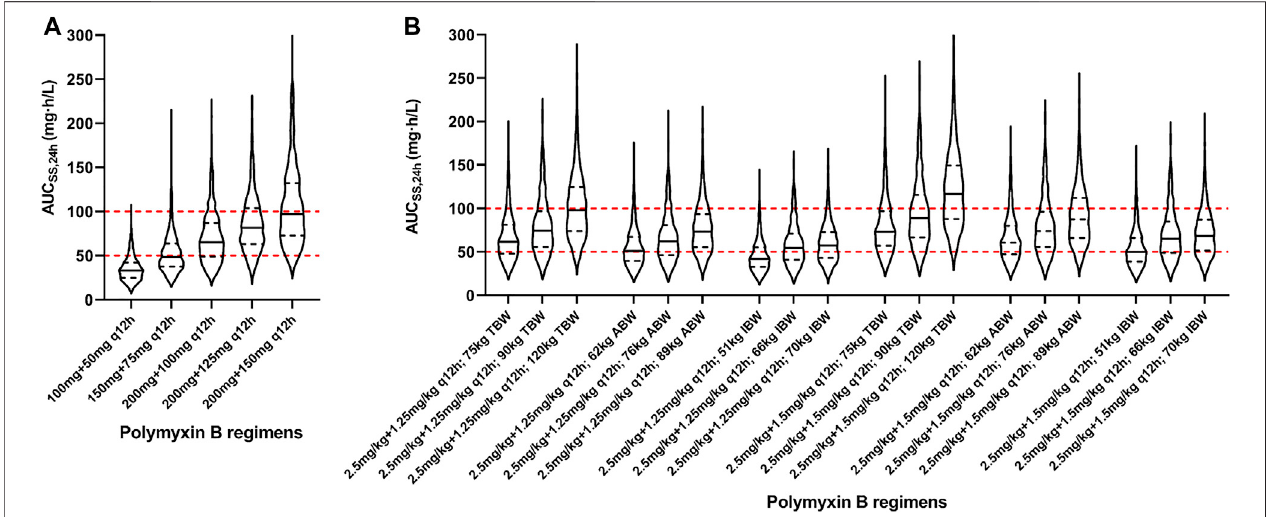
FIGURE 4 | Violin plot of simulation results of polymyxin B exposures (AUC ss,24h ). (A) Five fi xed regimens; (B) Bodyweight-based regimens. The dot lines present the interquartile of simulated exposure; the solid lines present the median of simulated exposure; the red dashed lines present the upper and lower limit of targeted exposure (50 – 100 mg